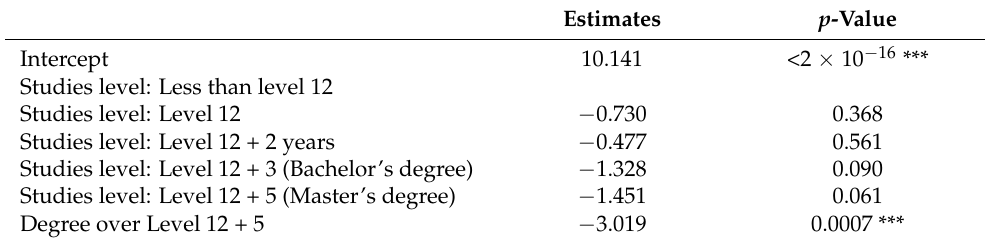
Table 6. One-way ANOVA results looking for a link between EDI-DT score and level of education. Estimates p -Value Intercept